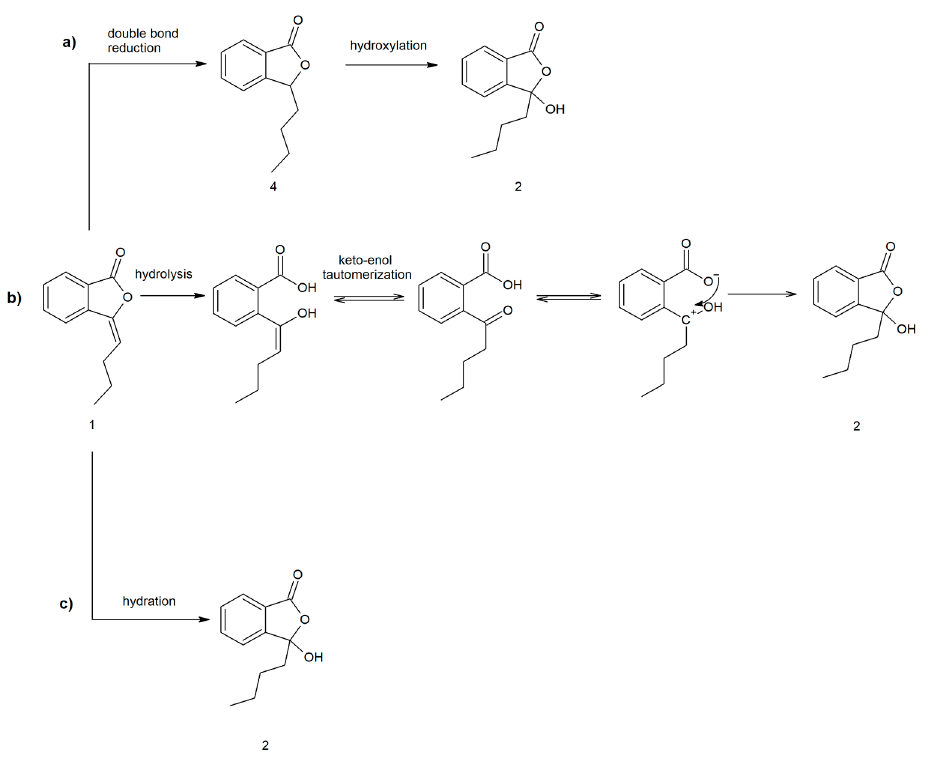
Figure 6. Proposed mechanism of 3-butyl-3-hydroxyphthalide ( 2 ) formation via ( a ) the intermediary product 3- n -butylphthalide ( 4 ); ( b ) hydrolysis of 3- n -butylidenephthalide ( 1 ) and ( c ) hydration of 3- n -butylidenephthalide ( 1 ).